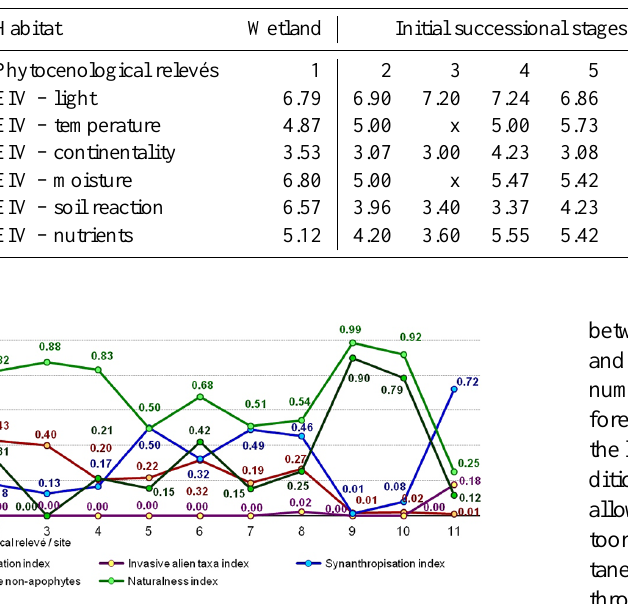
Figure 3. Indexes of metallophytisation, invasive alien taxa propor- tion, synanthropisation, non-native apophytes proportion and natu- ralness